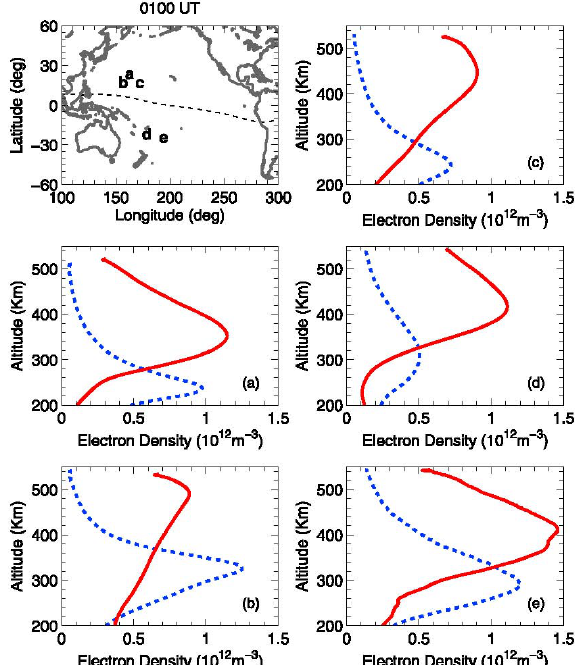
Fig. 40. Comparison of vertical electron density profiles from COS- MIC on 14 December 2006 (before the geomagnetic storm, dashed blue) and 15 December 2006 (after the storm, solid red). The loca- tions of the electron density profiles are indicated in the map at the top left (Pedatella et al.,